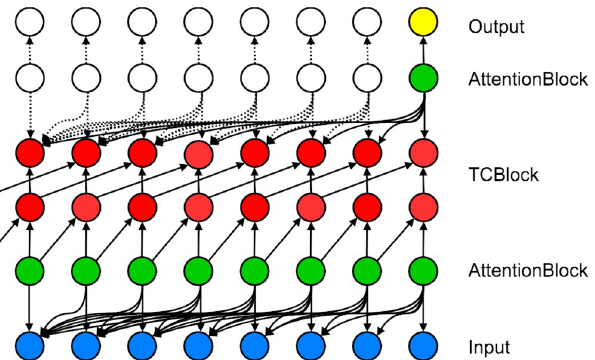
Fig 4. SNAIL architecture. A schematic view of SNAIL with one TCB LOCK and two A TTENTION B LOCK s. The blue circles correspond to an input layer, the red circles correspond to hidden layers, the yellow circles correspond to an output layer, and the green circles correspond to attention